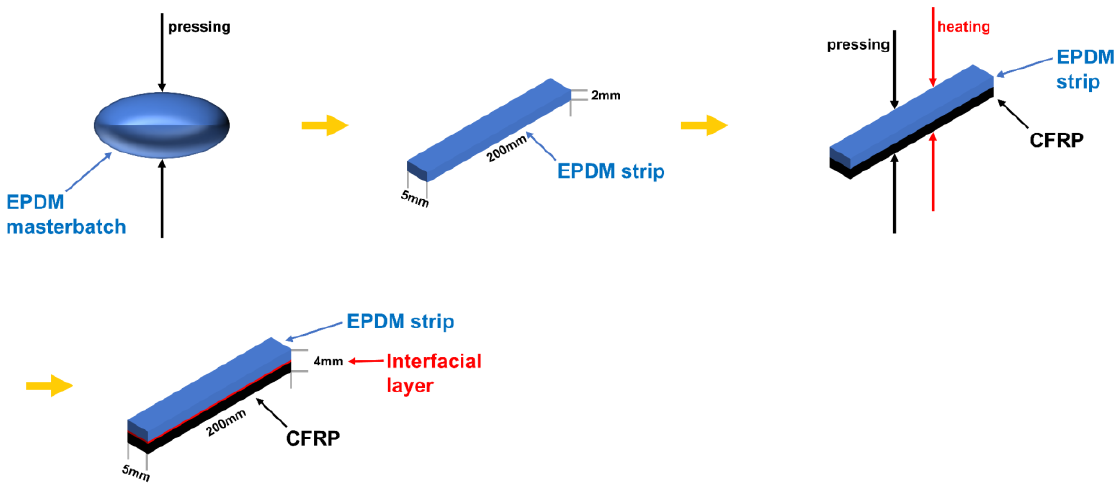
Figure 1. The manufacturing procedure of CFRP/EPDM composite.